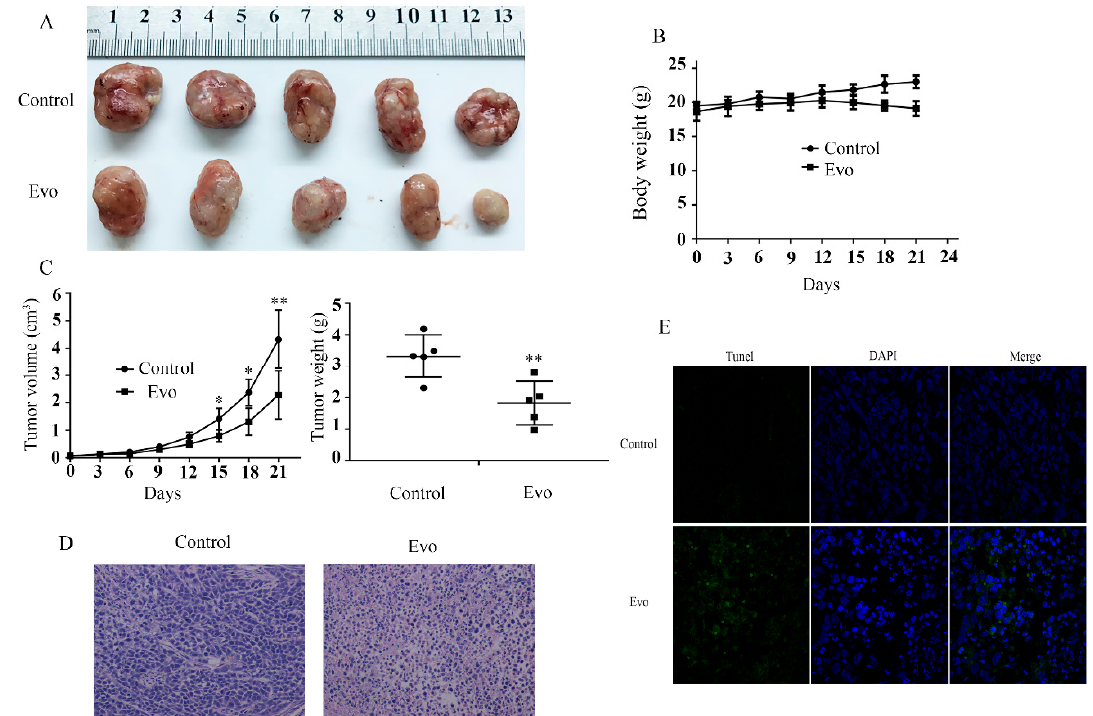
Figure 4. Evo inhibits HCC cells growth in vivo. ( A ) Representative images of the tumor generated by controls and Evo treatments. ( B ) Mice body weights were recorded and compared. ( C ) Tumor volumes were recorded and compared. Tumor weight was obtained at the end of the experiment when mice were sacrificed by dislocation after anesthesia. ( D , E ) Xenograft tumor tissues were analyzed for hematoxylin-eosin staining (HE) staining ( × 200) and TdT-mediated dUTP Nick-End Labeling (TUNEL) ( × 400). Values are means and standard errors of five separate experiments (* p < 0.05 and ** p < 0.01 versus control).